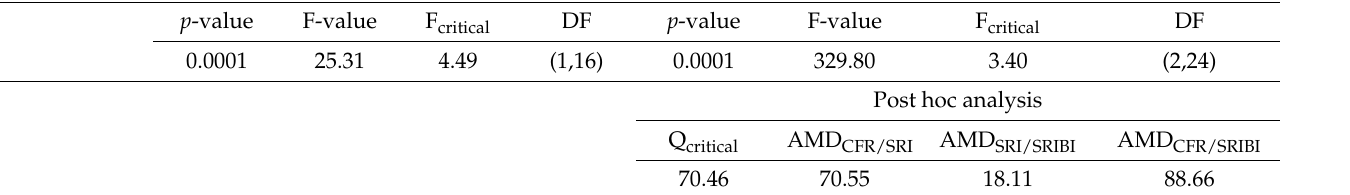
Figure 5. The spikelet number per panicle (SNPP) observed in the field experiments ( Left : 2019; Right : 2020). Table 8. Parameters from ANOVA statistical analysis for spikelet number (SNPP) comparison. SNPP